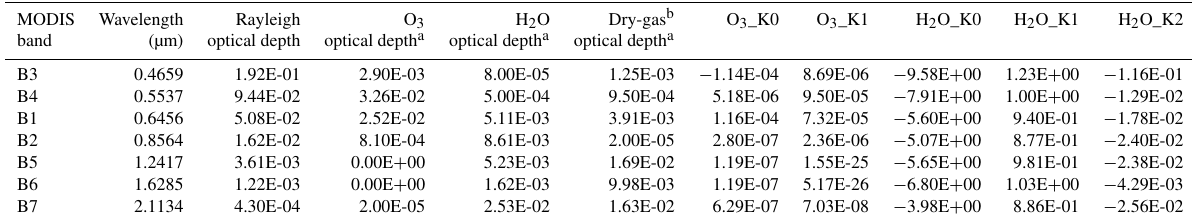
Table 4. Gas absorption coefficients and climatology for MODIS.